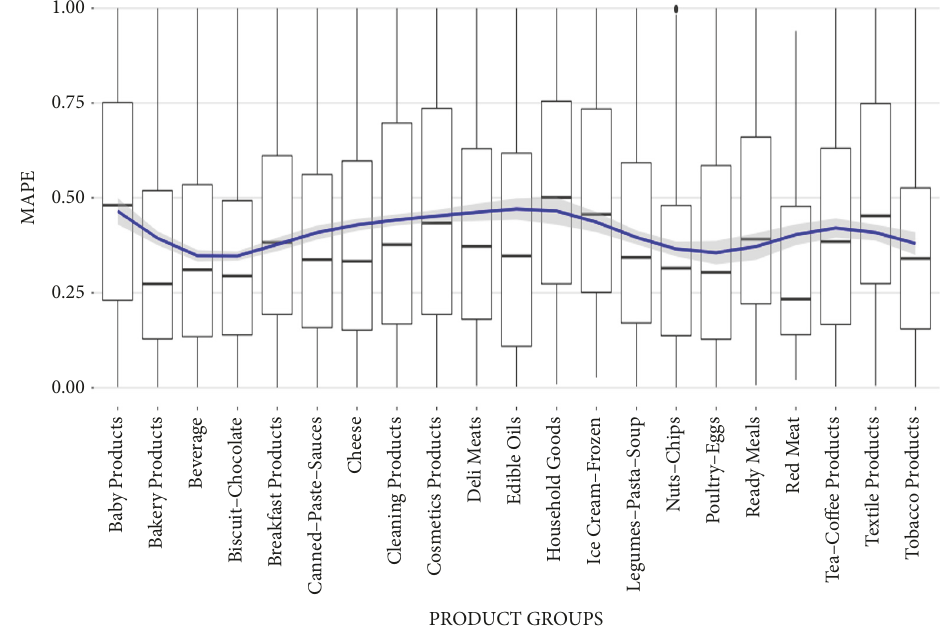
Figure 2: MAPE distribution according to product groups with S 1 integration